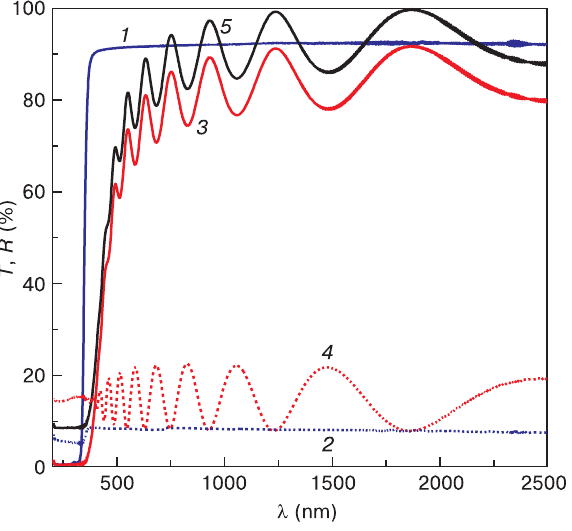
Figure 4. Light reflection measurement data for 10 deg inci - dence angle on specimen taken at ( 1 ) fused quartz substrate side and ( 2 ) film